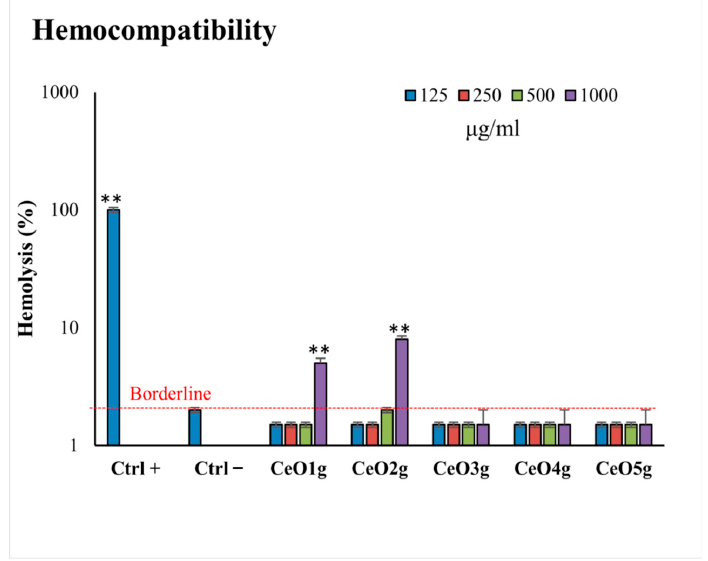
Figure 5. Hemolytic activity (hemocompatibility) of the tested CeO 2 NPs at different concentrations (125–1000 μ g/mL). ** indicates a statistically significant difference ( p < 0.001) between erythrocytes with NPs and negative control of hemolysis (CTRL − ).